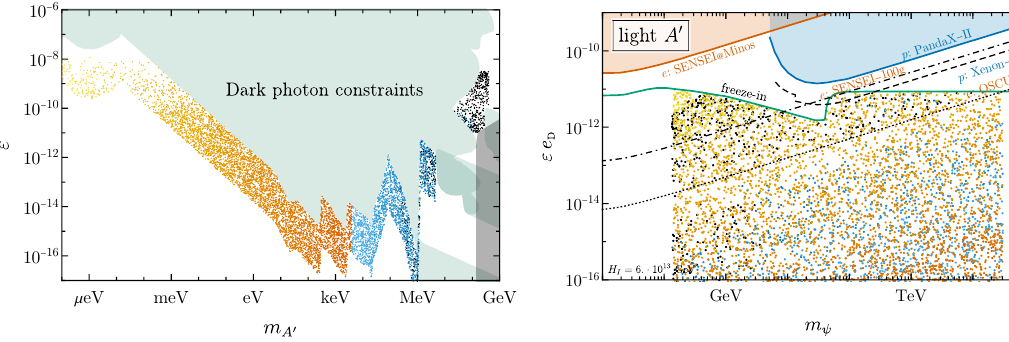
Figure 18. Scatter plot sampling our 4-dimensional parameter space ( m ψ , e d , m A 0 , ε ) , with the goal of identifying points that allow for a successful production of DM and are potentially close to discovery in the dark photon parameter space. The detection of the dark fermion in the favored region (shown in figure 9 and in the right plot) would be suggestive of our mechanism and provide indication on the favoured range for m A 0 to be successfully probed. Left: projection in the ( m A 0 , ε ) parameter space. We sample values of ε that are within 2 orders of magnitude from present bounds (for which we refer to figure 8). The points are coloured according to whether A 0 is a light enough mediator for ψ direct detection: orange/red refers to light mediator for electron scattering ( m A 0 smaller than the typical momentum transfer α em m e ) and nuclear scattering on Xenon ( m A 0 < µ ψN v DM , where µ ψN is the reduced mass of ψ and the Xe nucleus), blue for only nuclear Xe Xe scattering, and black for the remaining points. The depletion of points in the upper left corner is due to the requirement of having a dark electromagnetic cascade (see figure 16). Right: projection in the ( m ψ , εe d ) plane which is relevant for direct detection. Orange/red points are within reach of both electron (SENSEI, OSCURA) and nuclear recoil (PandaX, Xenon-nT) searches, whereas blue points are only within reach of nuclear recoil